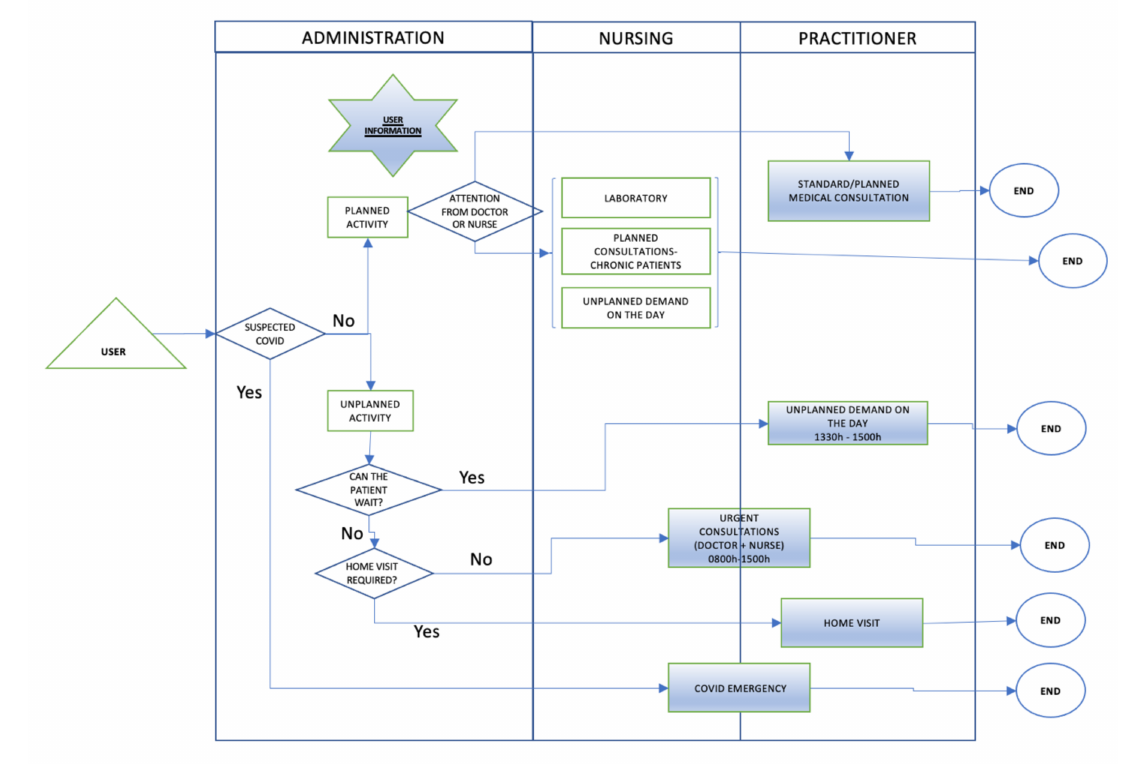
Figure 9. Covid-19 process diagram.